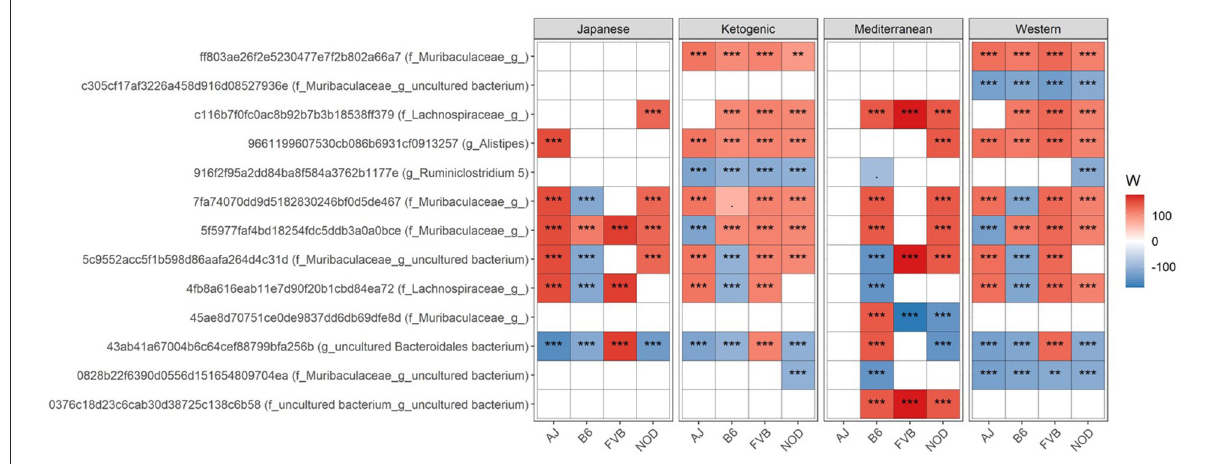
FIGURE2 Differential ASV abundance between controlled mouse diet and four popular human diet patterns. The top 20 most differentially abundant (based on cumulative ANCOM W-value) ASV were selected for the graph. On the Y-axis, maximum taxonomic information has been presented with the ASV ID. For easier presentation, ANCOM W values were converted to negative if the CLR mean abundance is lower in the popular diet patterns compared to control mouse diet. Red indicates higher ASV abundance in the popular diet pattern and blue represents higher ASV abundance in the control diet group. White represents a non-significant result obtained from ANCOM analysis. ANCOM models were FDR (BH-method) corrected and a significant sub-hypothesis test at a level of adj. P < 0.05 was counted toward W value. Models were adjusted for sex as a confounding factor and were stratified by mouse strains. “***” = ≥ W 0.9 , “**” = ≥ W 0.8 , and “.” = ≥ W 0.6 . The full list of the differential ASV abundance is available in Supplementary Table 3. Corresponding differential genera abundance has been depicted in Supplementary Figure 5, and the full list is available in Supplementary Table